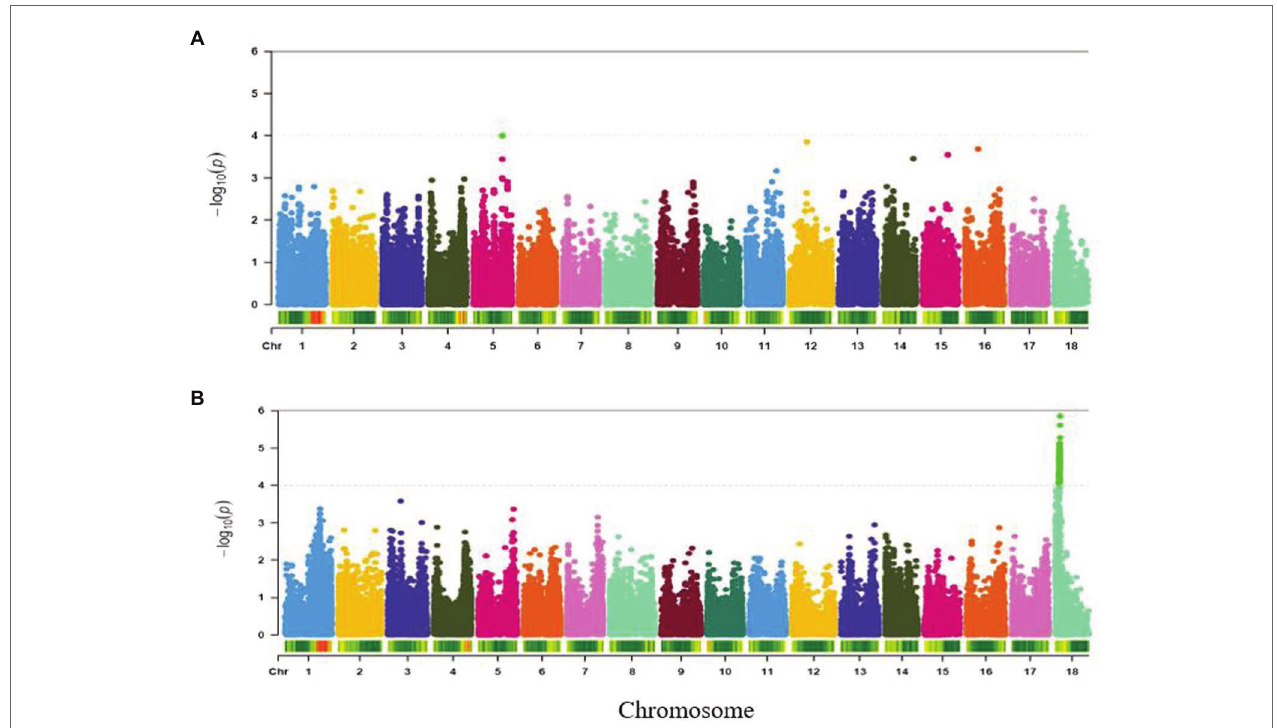
FIGURE 5 | Manhattan plots for GWAS based on best linear unbiased predictions for (A) fibre, and (B) adhesiveness. The dashed horizontal line depicts the genome-wide significance